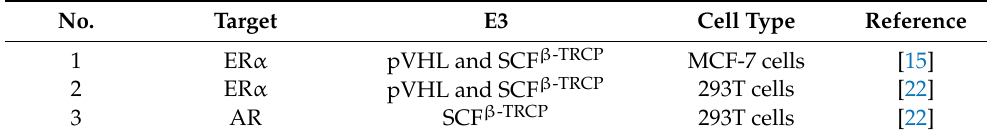
Table 2. Natural product targets